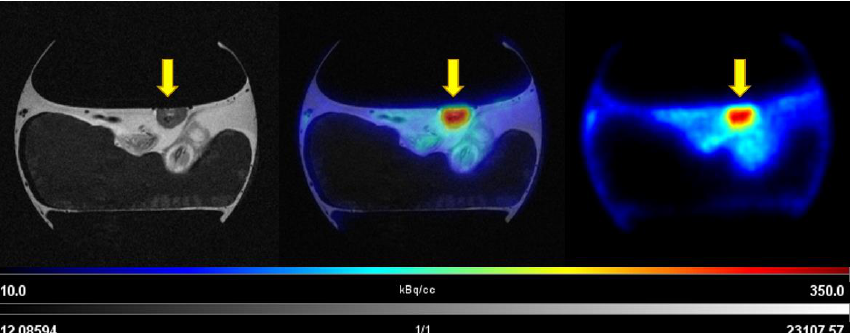
Figure 7. Representative images of 2-[ 18 F]FDG uptake into HCT116 CAM-xenograft. Uptake of 2-[ 18 F]FDG into the HCT116 xenograft after injection of 4.21 MBq 2-[ 18 F]FDG into a CAM-vessel on EDD18. PET imaging was performed 60 min p.i. Left: T2-weighted TurboRARE image, right: PET, middle: fused PET and MR (axial planes are shown).